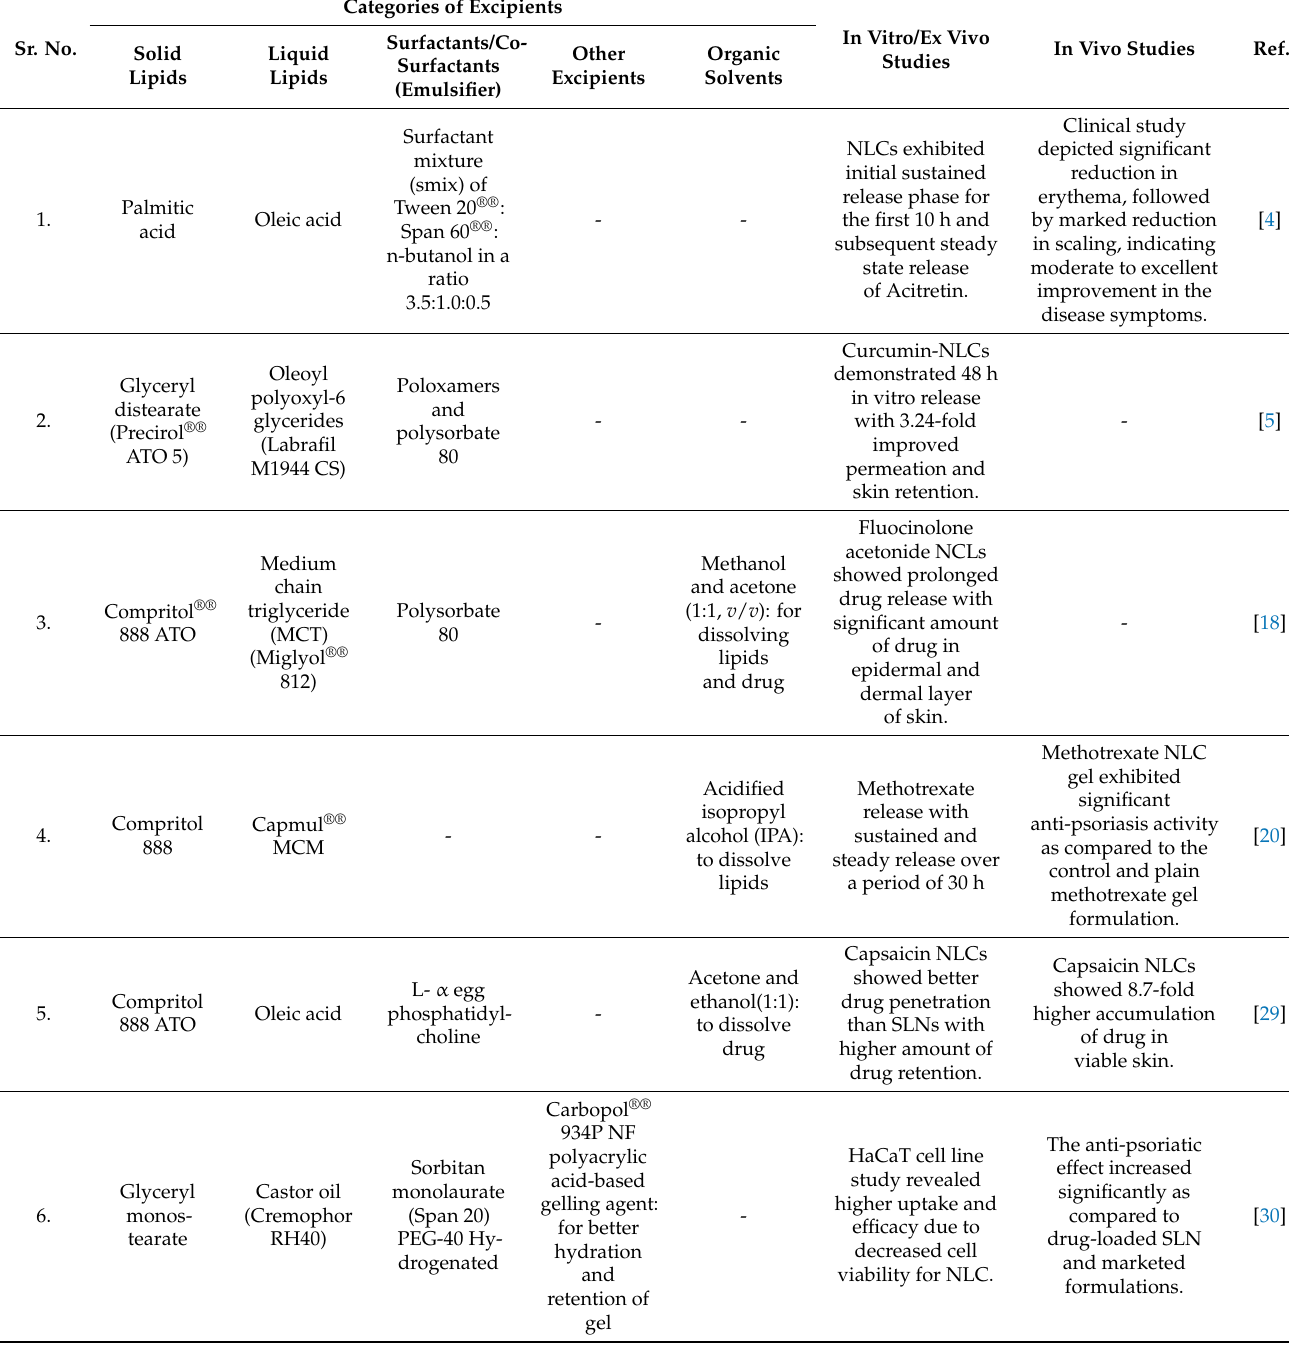
Table 2. Various solid lipids, liquid lipids, surfactants, other excipients, and solvents are used in the fabrication of NLCs in psoriasis